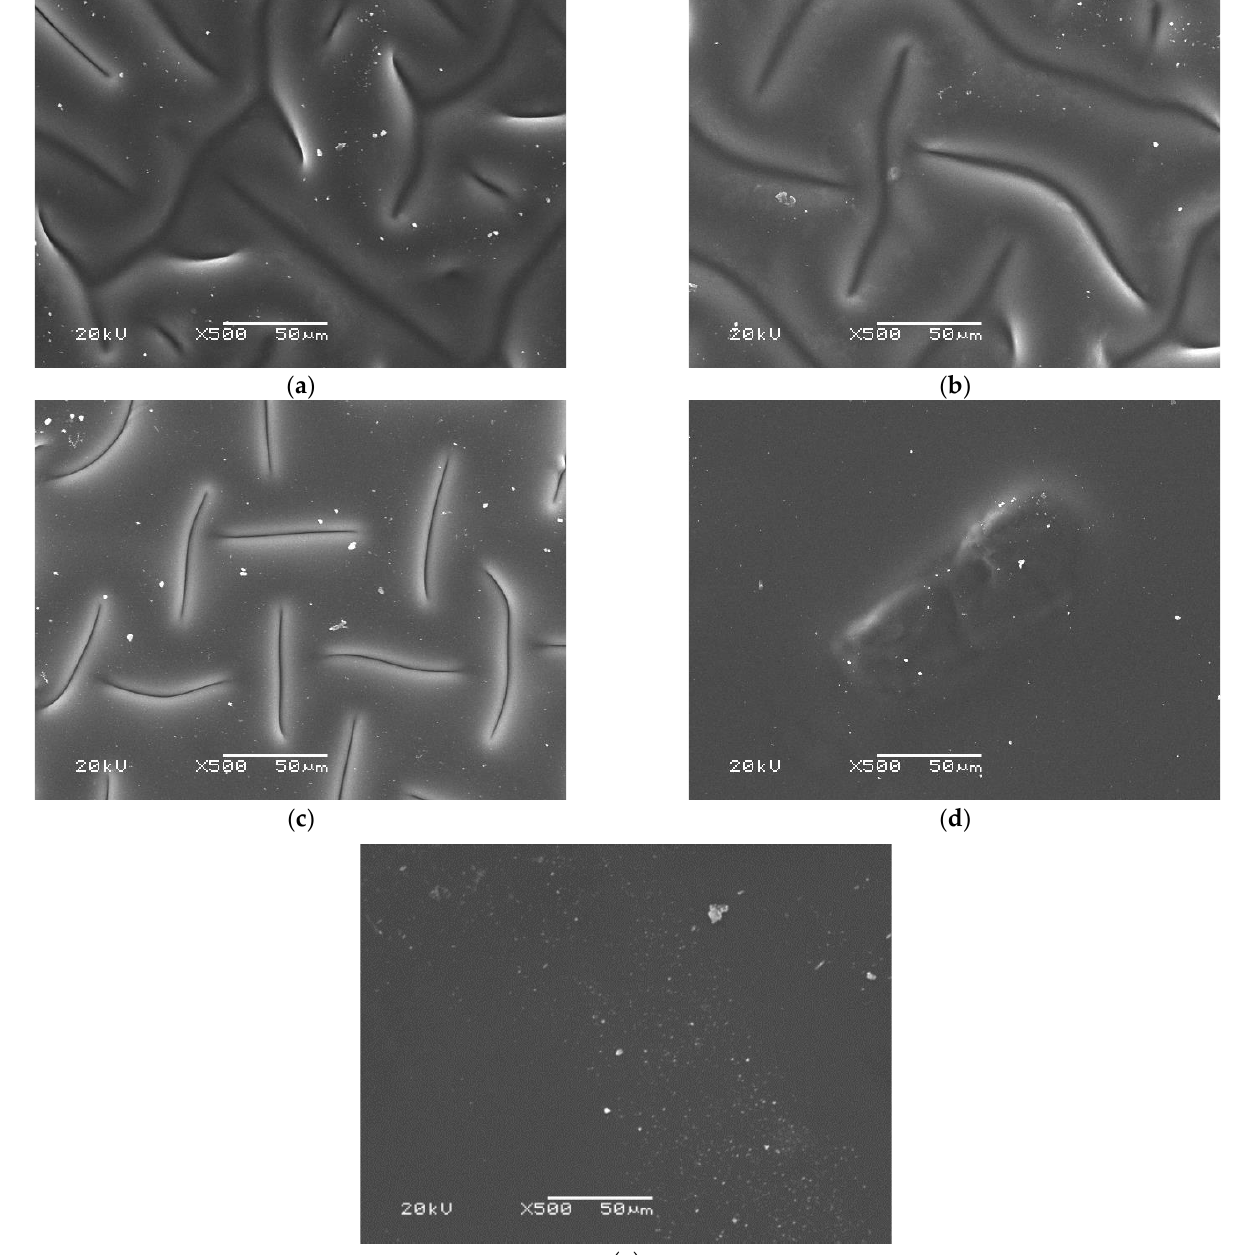
Figure 7. SEM image of sample 0.025/Photo ( a ), 0.075/Photo ( b ), 0.100/Photo ( c ), 0.125/Photo ( d ) and 0.150/Photo ( e ).